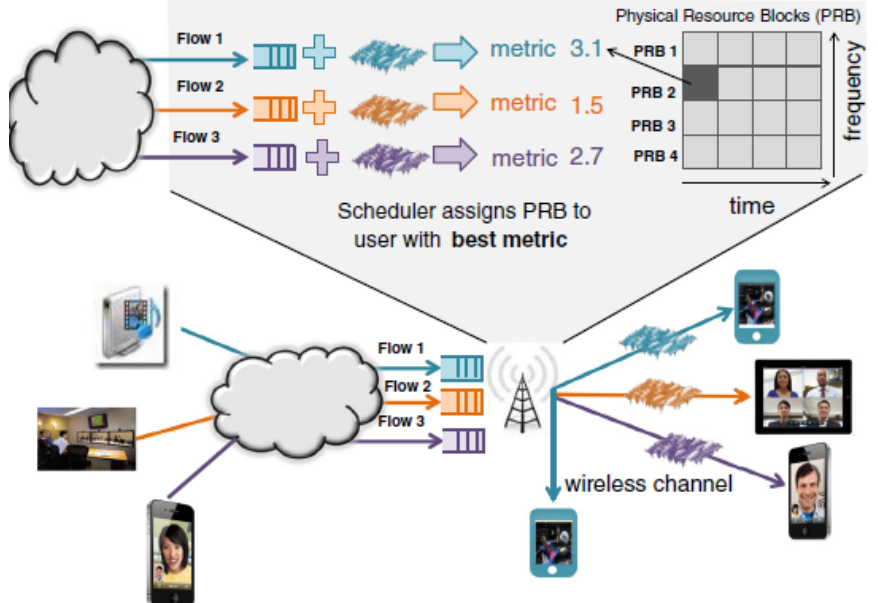
Figure 3. Time/frequency distribution of the physical resource blocks (PRBs) over one allocation